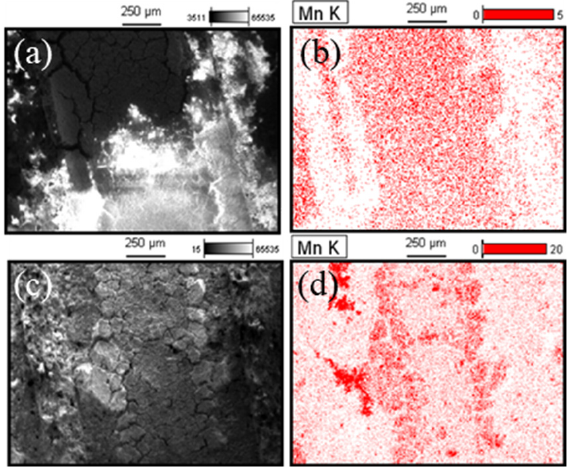
Figure 6. ( a ) SEM image of Mn/RM; ( b ) Mn distribution as obtained by EDS mapping in ( a ); ( c ) SEM image of Mn2/RM; ( d ) Mn distribution as obtained by EDS mapping in ( c ).